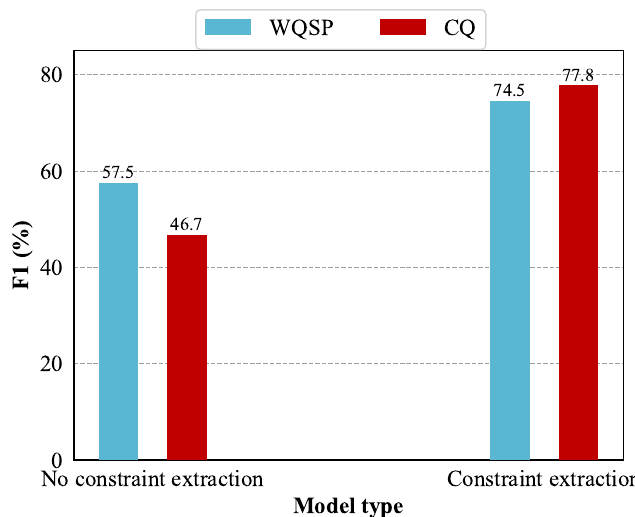
Figure 11. The impact of the constraint extraction model on HBHR